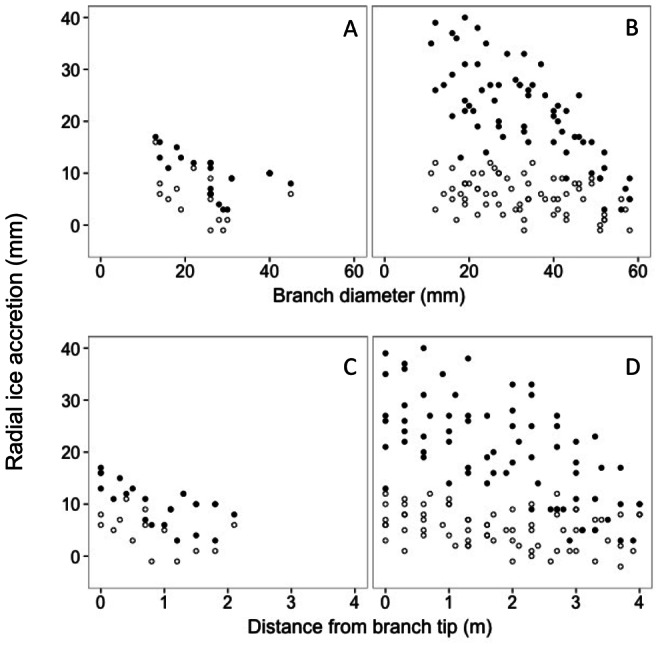
Change in radial ice thickness as measured by increasing distance from branch tips (A, B) or increasing diameter along branches (C, D) for upper (B, D) and lower (A, C) relative positions in the crown.Hollow circles indicate data collected at the first scanning and solid circles the second scanning (details in Table 1). Fitted model coefficients presented in Table 3.